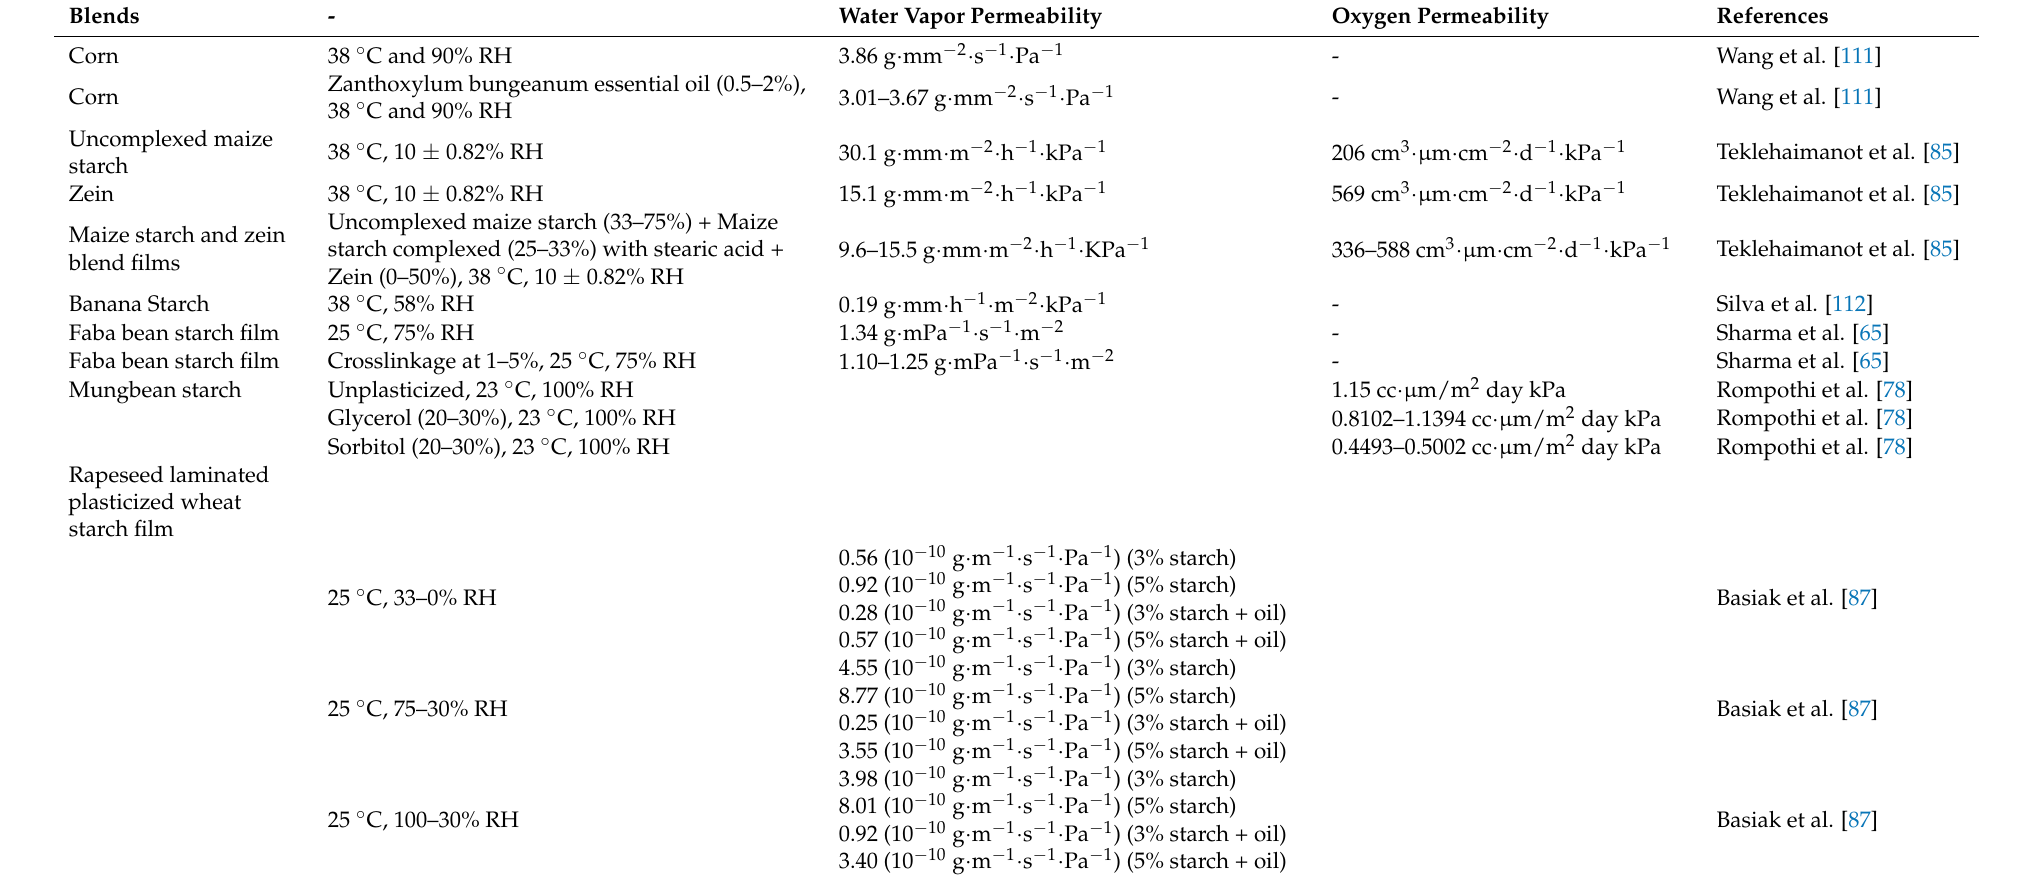
Table 1. Barrier properties of the starch-based